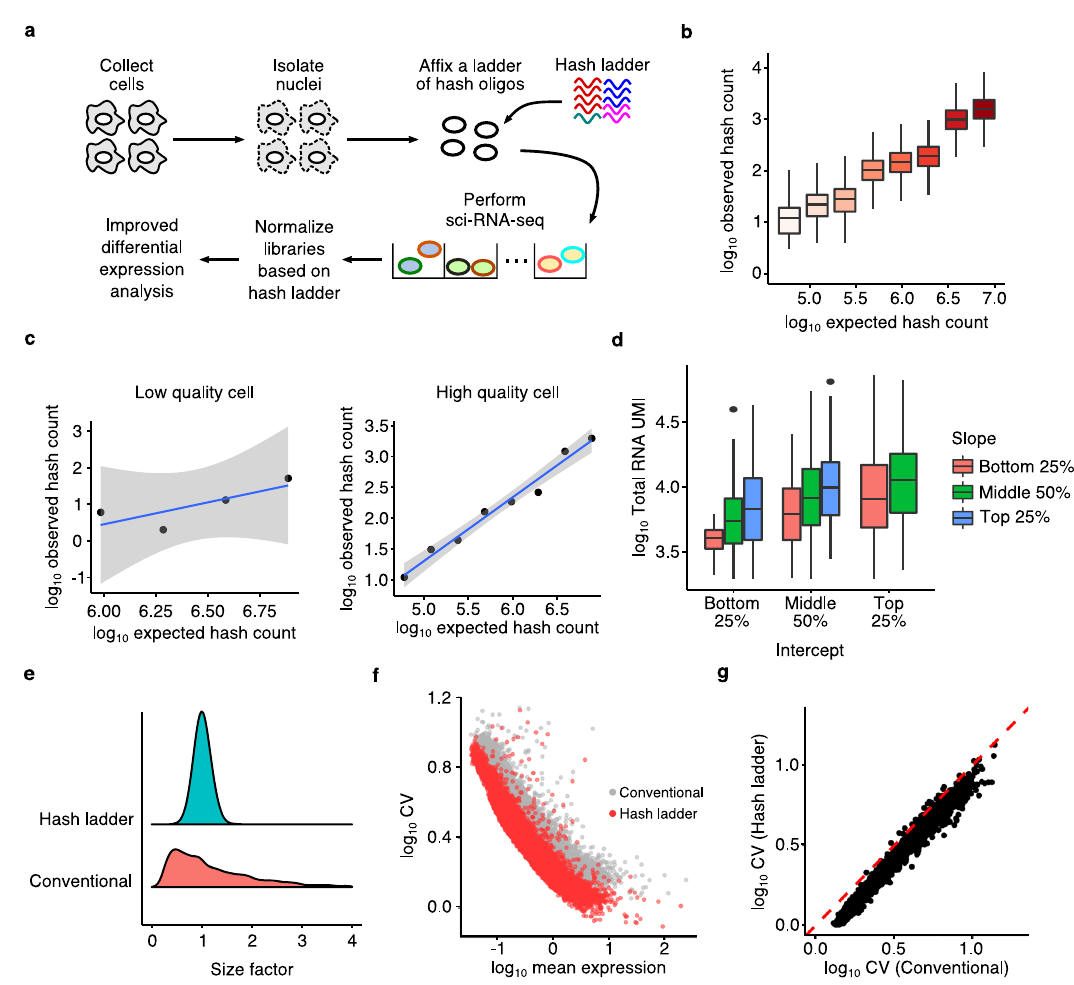
Fig. 1 A set of hash oligos can be captured within nuclei and serve as external standards in sci-RNA-seq experiments. a An experimental overview of the hash ladder method. Nuclei are isolated from cells, fi xed with a ladder of hash oligos, then processed with sci-RNA-seq. b Boxplot of hash oligo UMI counts per cell, each hash oligo spiked in at different abundance ( n = 1884 cells). c Scatter plot of expected and observed hash ladder UMI counts, demonstrating a cell with low (left) and high (right) hash capture ef fi ciency. d Boxplot of total RNA count of cells grouped according to the intercept and slope of their hash ladder calibration line ( n = 1884 cells). e Distribution of cell-speci fi c size factors computed using the conventional and hash ladder methods. f Scatter plot of normalized average expression and coef fi cient of variation (CV) of expressed genes in HEK293T. g Comparison of CV values computed with the conventional and hash ladder-based normalization methods. The centerline of the boxplots in b and d indicates the median, the box displays the fi rst and third quartile, and the whiskers show the 1.5 interquartile range (IQR). Outliers are displayed as